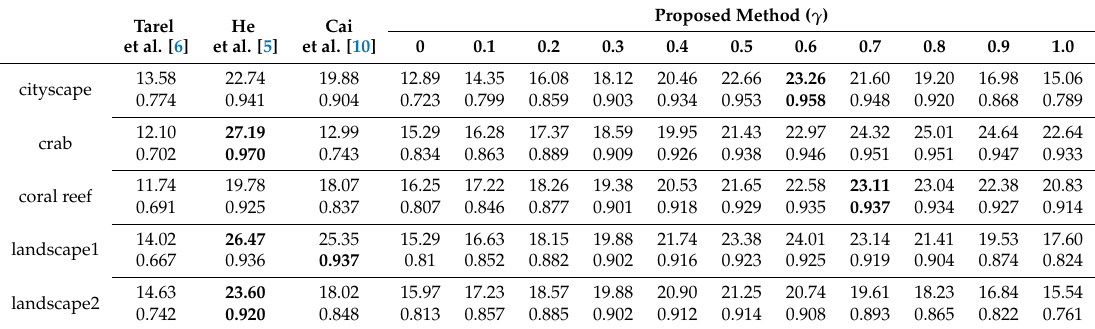
Table 2. Quantitative evaluation with PSNR and SSIM [24] for simulated haze images generated using nonuniform transmission map. First row is PSNR value, and second row is SSIM value in each cell. Proposed Method ( γ ) Tarel He Cai et al. [6] et al. [5] et al. [10] 0 0.1 0.2 0.3 0.4 0.5 0.6 0.7 0.8 0.9 1.0